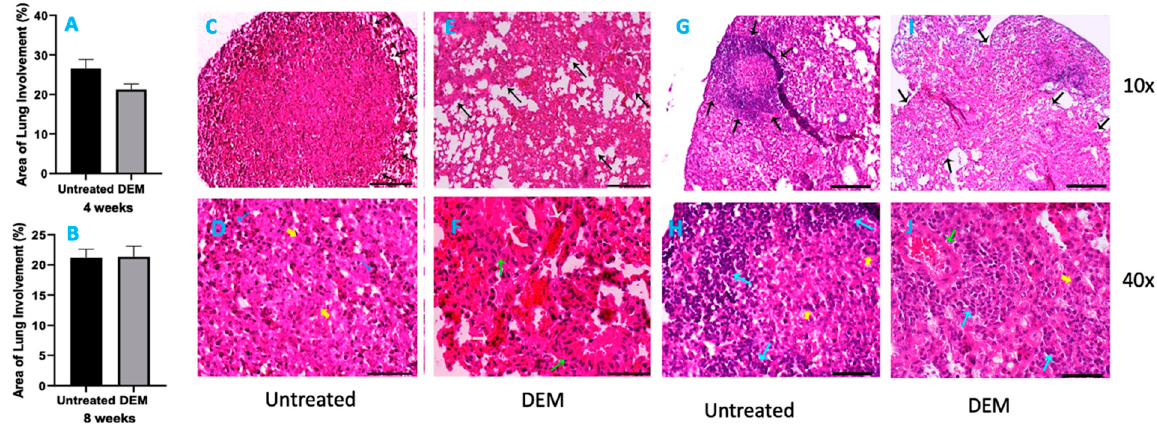
Figure 6. Morphometric analysis and hematoxylin and eosin staining of lung tissue sections of M. tb -infected mice that were sham-treated or treated with DEM. Morphometric analysis was performed in the mouse lung sections stained with hematoxylin and eosin at 4 weeks ( A ) and 8 weeks ( B ) post- M. tb infection. 10 × ( C , E , G , I ) and 40 × ( D , F , H , J ) images of hematoxylin and eosin-stained lung sections of mice at 4 weeks ( C – F ) and 8 weeks ( G – J ) post- M. tb infection are presented. The sample size ( n ) includes six mice each in the untreated and DEM-treated groups.